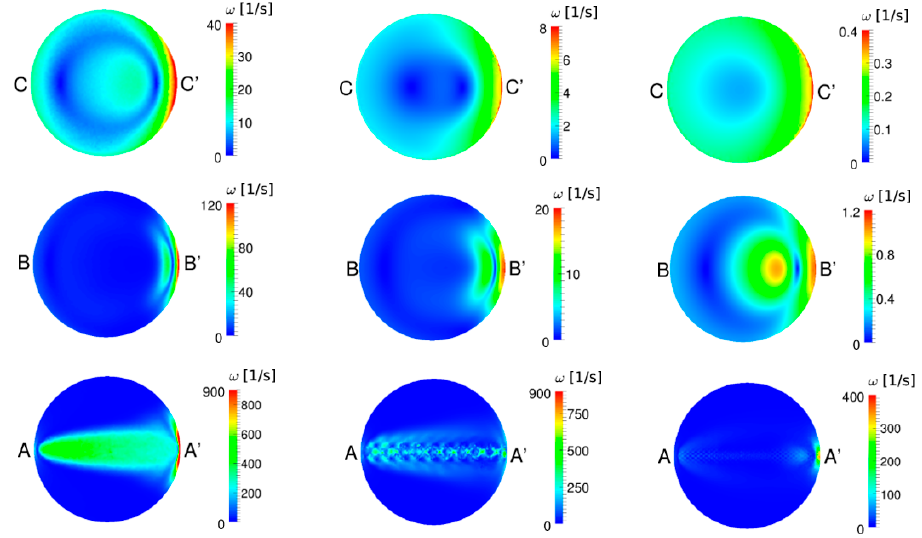
Figure 8. Vorticity contour at different cross-sections of the ( left ) UA, ( center ) RS, and ( right ) FD at peak systole.